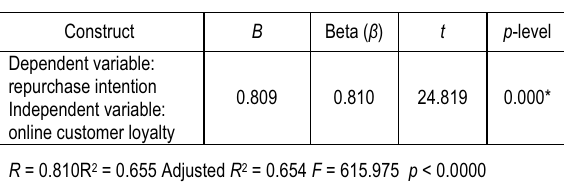
Table 9. Regression analysis: online customer loyalty and repurchase